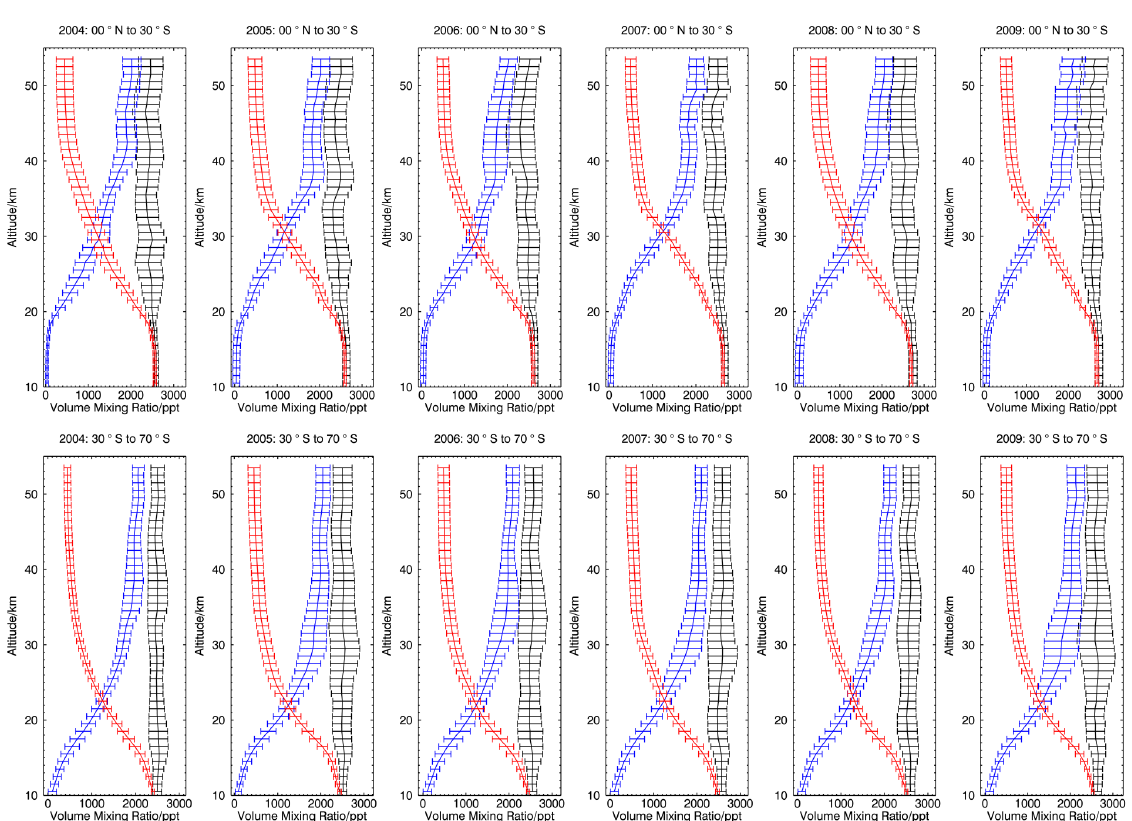
Fig. 2. As Fig. 1 but for latitude bands 0–30 ◦ S and 30–70 ◦ Figure 2: As Figure 1 but for latitude bands 0 o -30 o S and 30 o S-70 o S.